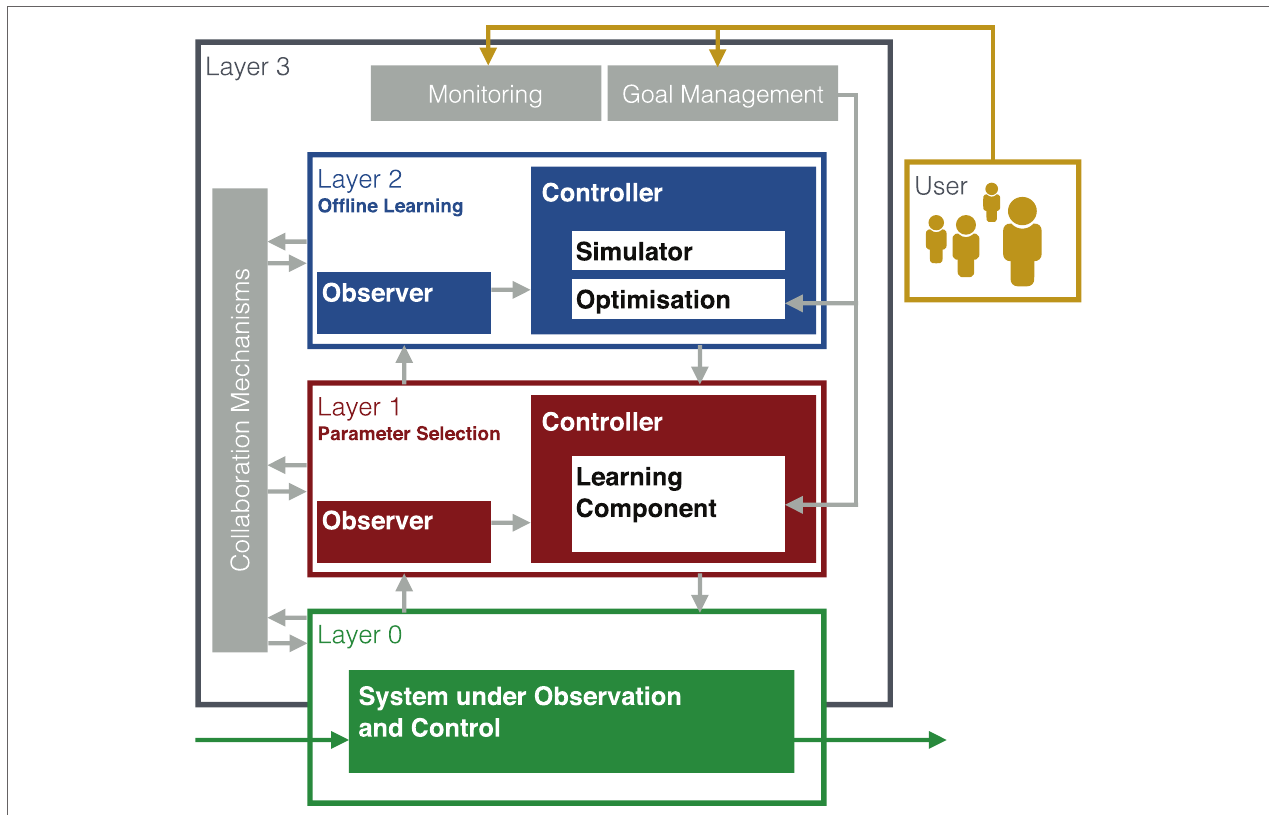
FigUre 1 | Multi-level observer/controller architecture . The System under Observation and Control (SuOC) at the bottom is observed and adjusted by the O/C layers above. Their responsibilities are (in this order): reinforcement of existing behavior, innovating new behavior, and interfacing local behavior with (a) user-set targets and (b) cooperative units’ goals. Figure adapted from Müller-Schloer et al.